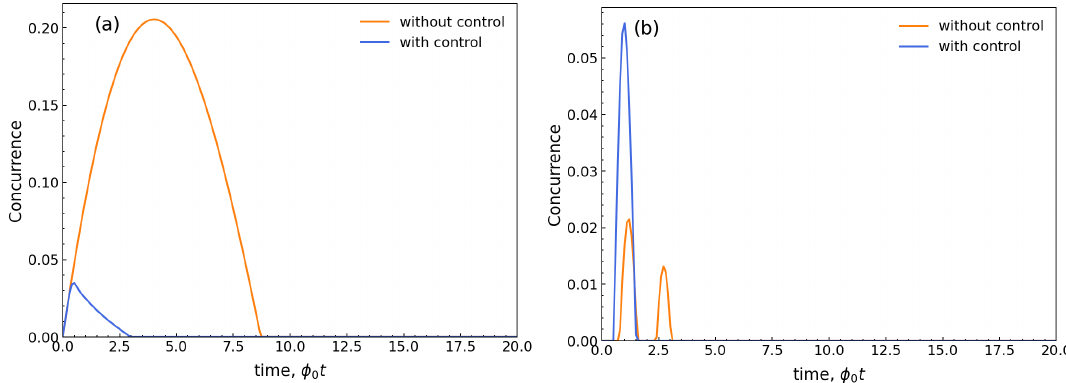
Figure 9: Concurrence of uncontrolled and optimally controlled (for local phase es- timation) two-qubit systems under ZZ (a) and XX (b) couplings. The probe state is | ++ 〉